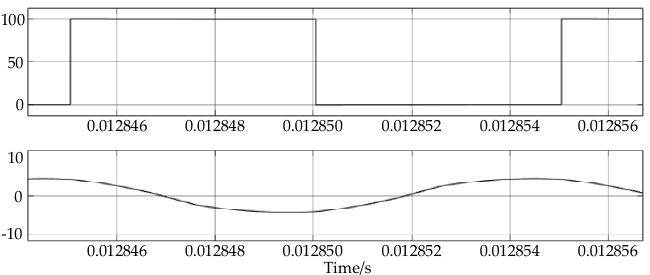
Figure 27. φ AD = 92° and φ AB = 239° bridge-arm A drain-source voltage and current waveforms. Figure 27. ϕ AD = 92 ◦ and ϕ AB = 239 ◦ bridge-arm A drain-source voltage and current waveforms.